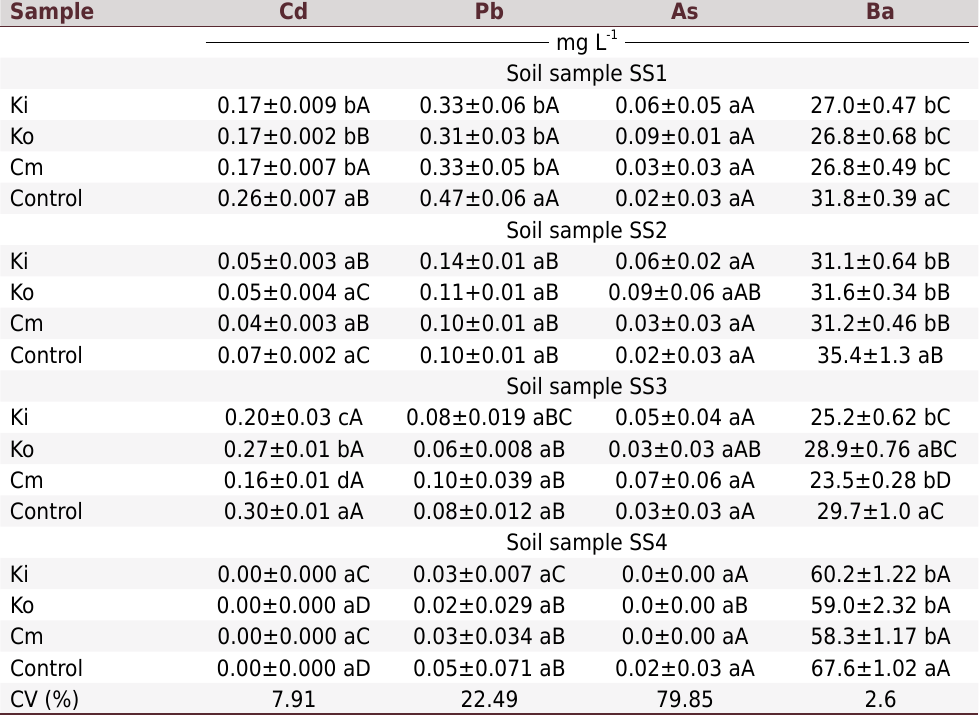
Table 4. Available heavy metal contents in soil samples after application of bacterial inoculum